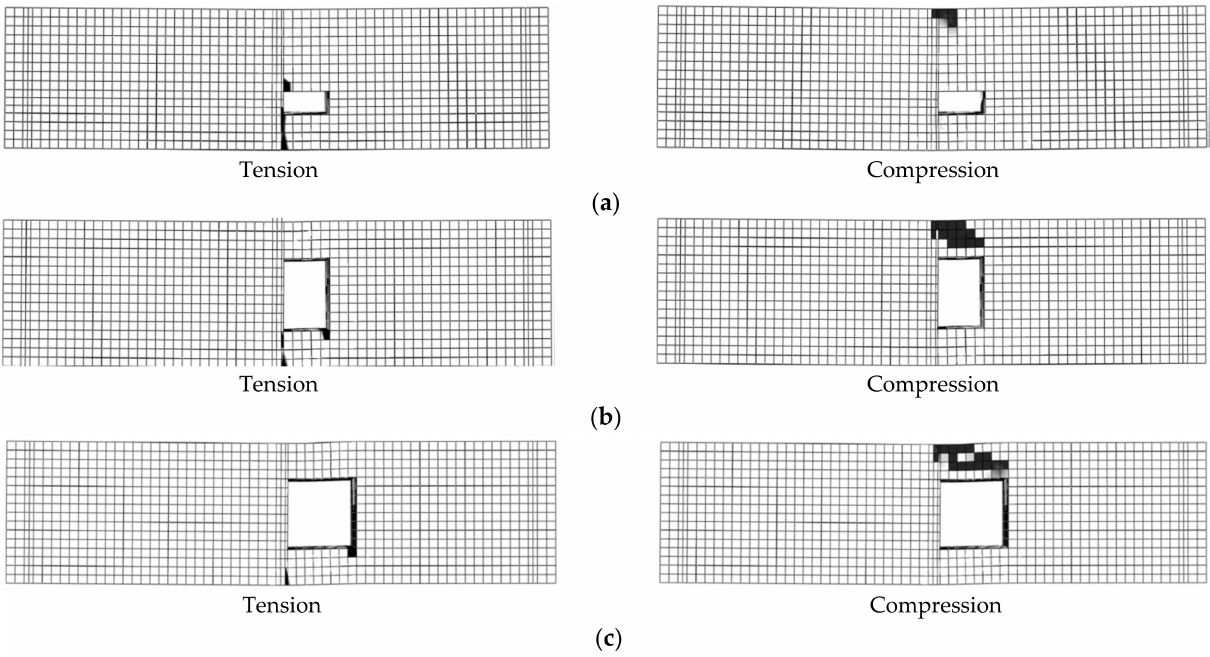
Figure 8. Failure modes of beams with transversal near center opening (group 1): ( a ) Beam B5-1; ( b ) Beam B5-3; ( c ) Beam B5-6.